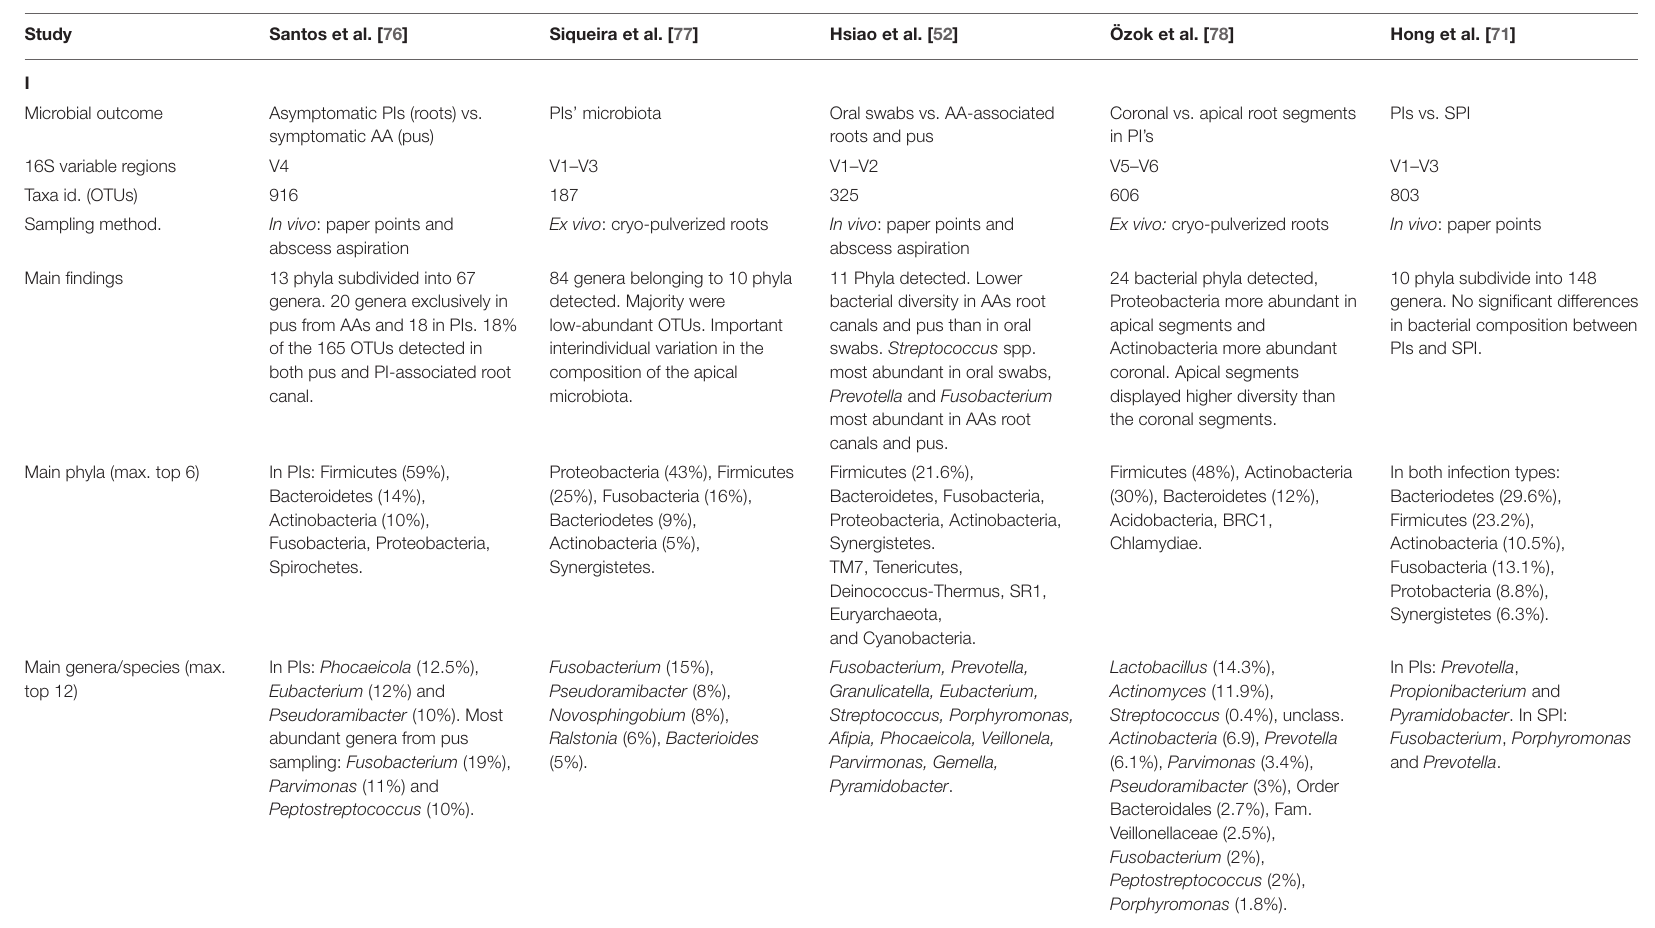
TABLE 1 | Overview of the studies included that investigated the root canal microbiota by means of 16S rRNA gene next-generation